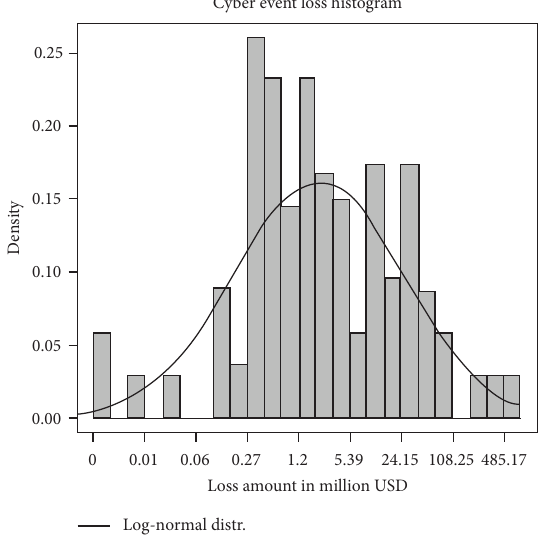
Figure 14: Cyber fraud loss severity histogram and its assumed distribution.